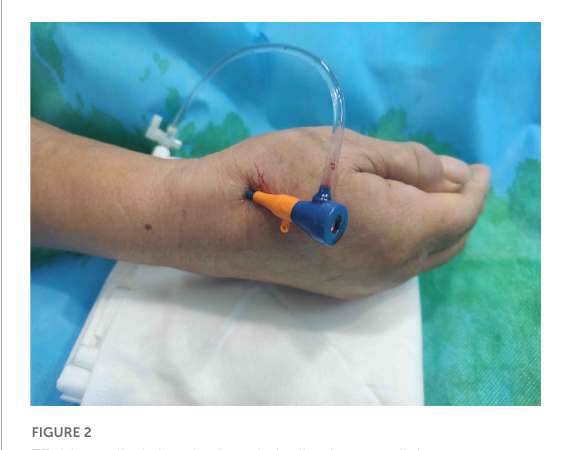
FIGURE2 7F thin-walled sheath placed via distal transradial artery.